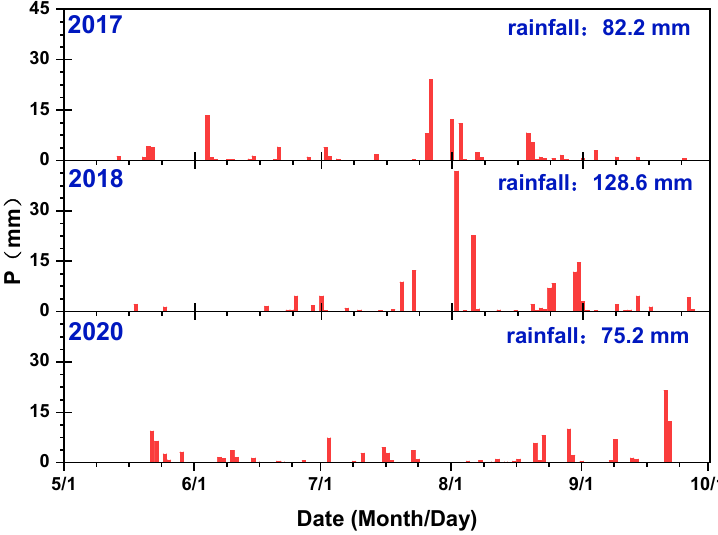
Figure 7. Rainfall during soybean growth period in 2017, 2018, and 2020.